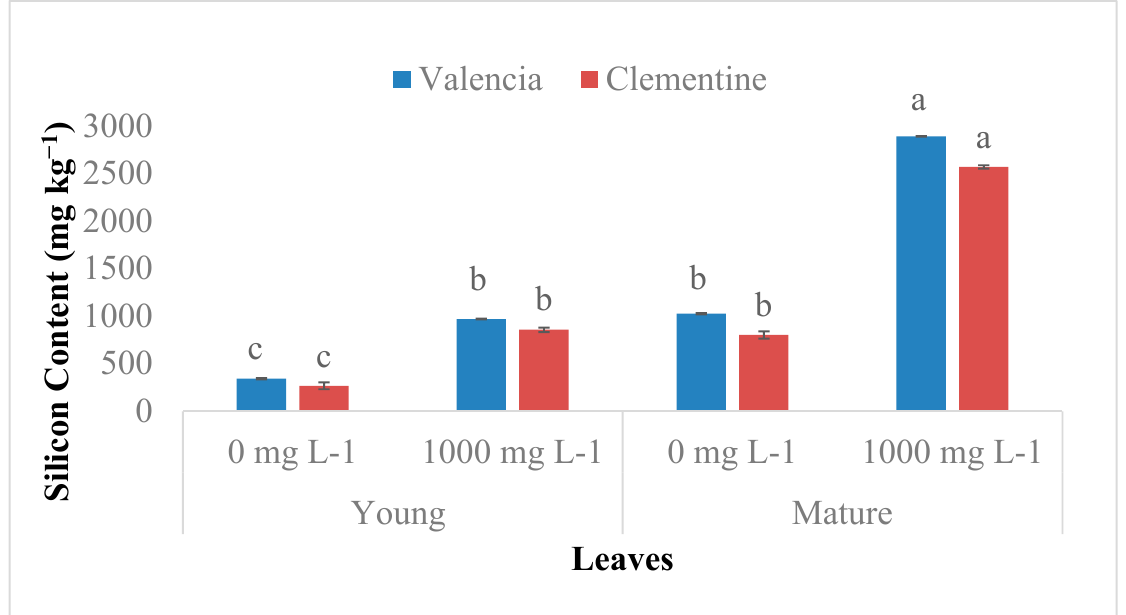
Figure 1. Si accumulation in young (new) and mature (old) leaves of two citrus species. Bars sharing a letter are not significantly different. Data are means ± standard errors.